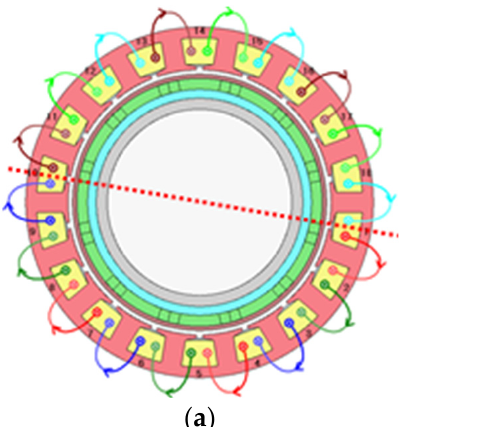
Table 5. DL/SL feasibility and fault tolerance (FT) of dual three-phase winding.